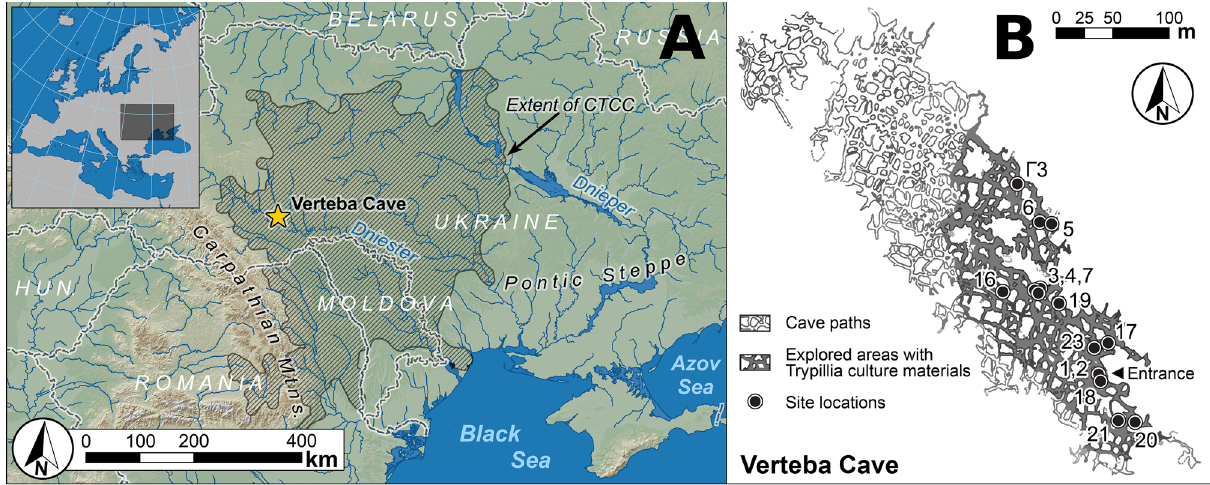
Figure 1. ( A ) Location of Verteba cave in Ternopil Oblast, Ukraine, plotted against the overall distribution of CTCC sites. ( B ) Map of sites within Verteba cave; individuals included in this publication were found at sites 7, 17 and 20, Adapted from Ledogar et al. 31